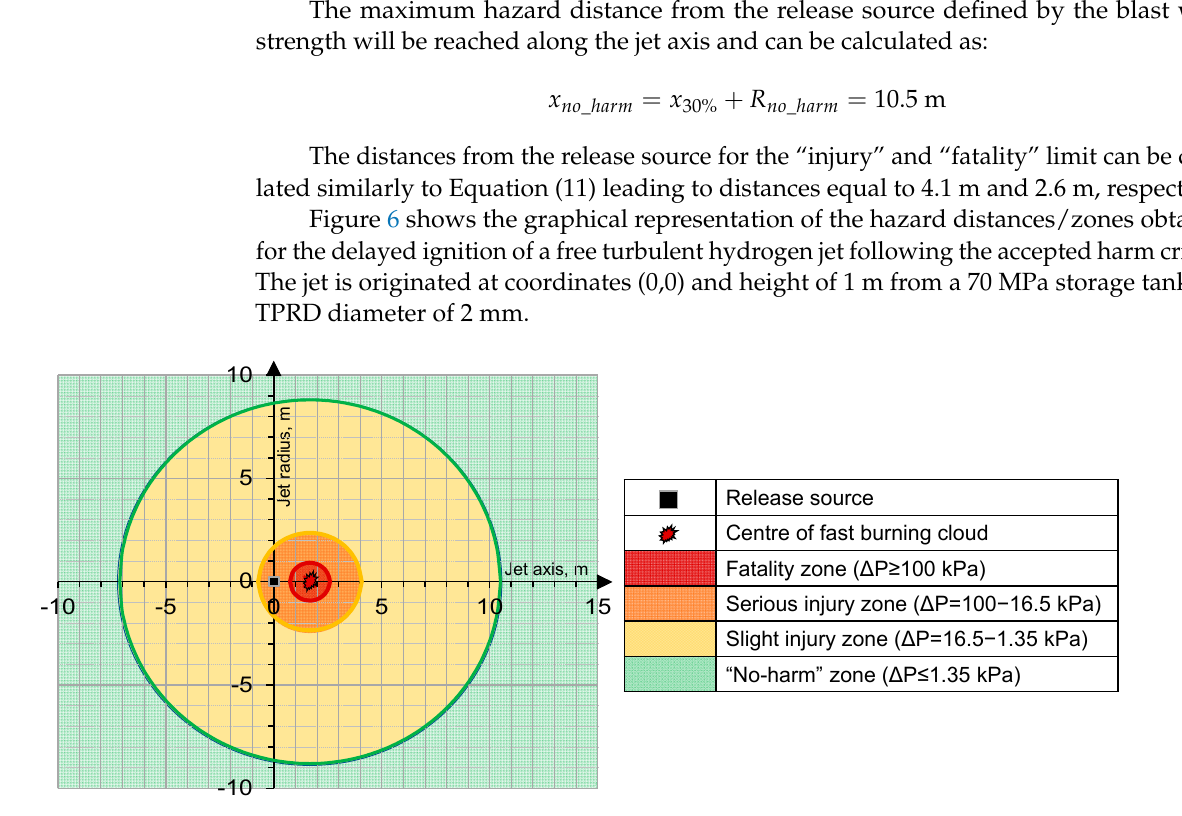
Figure 6. Four hazard zones (fatality, serious injury, slight injury and no-harm) corresponding to three hazard distances (correspond to three pressure thresholds of harm to humans—fatality, injury and no-harm) for the free horizontal jet from TPRD = 2 mm and hydrogen storage pressure 70 MPa.